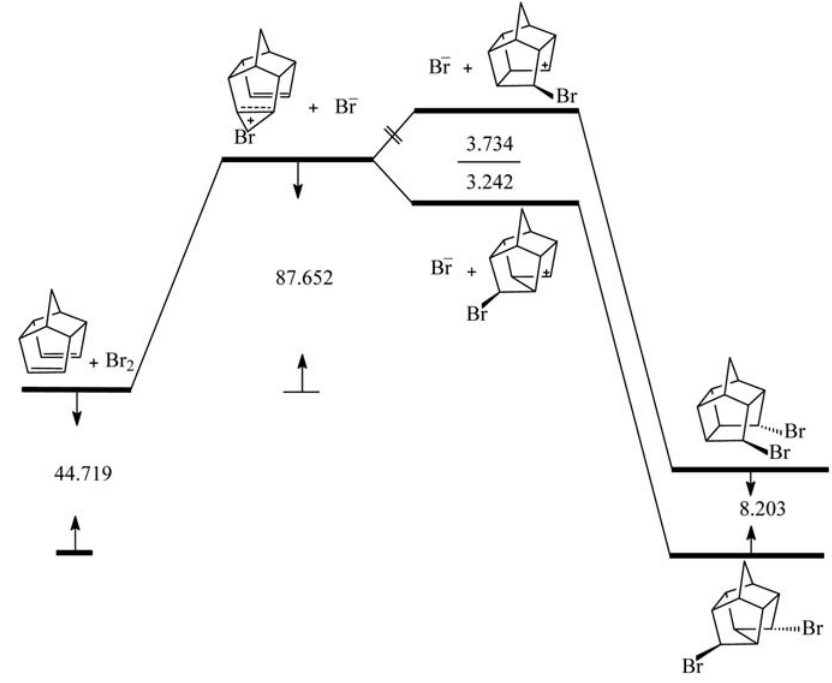
system (kcalmol –1 ) [ B3LYP/6-311++G(2d,2p)//B3LYP/6-311G(d,p) ] 2